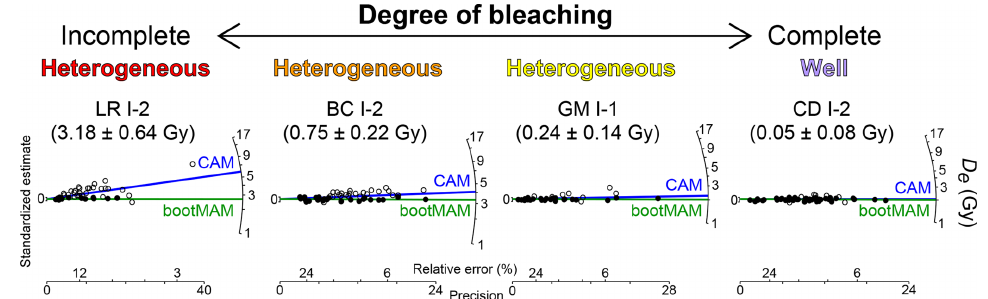
Figure 2. Radial plots of four mouth bar sand samples provide an example of our approach to assessing the degree of bleaching of Late Holocene deposits. Our assessment is based on the residual dose, given in parentheses, obtained from the difference in equivalent doses ( D e ) estimated with the bootstrapped Minimum Age Model (bootMAM) and Central Age Model (CAM). Filled data points represent aliquots for which the D e estimate agrees with the sample D e obtained from bootMAM within 2 σ uncertainty. Adapted from Chamberlain et al. (2018b).